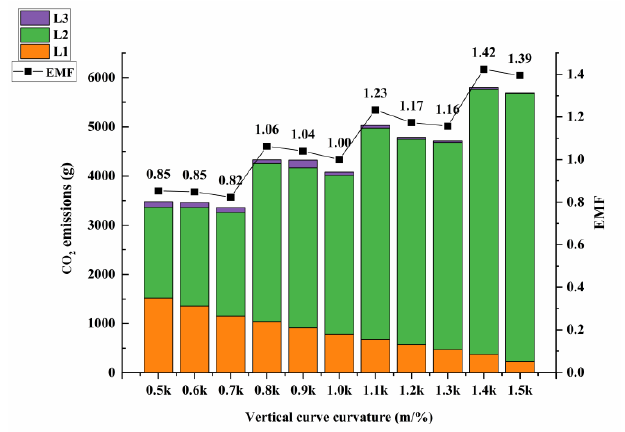
Figure 3. Relationship between CO 2 emissions and curvature.